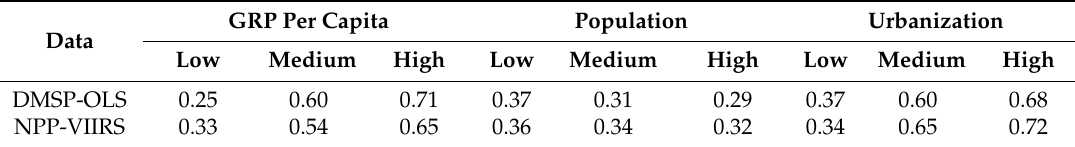
Table 4. The R 2 of TNL-CO 2 regression at different socio-economic